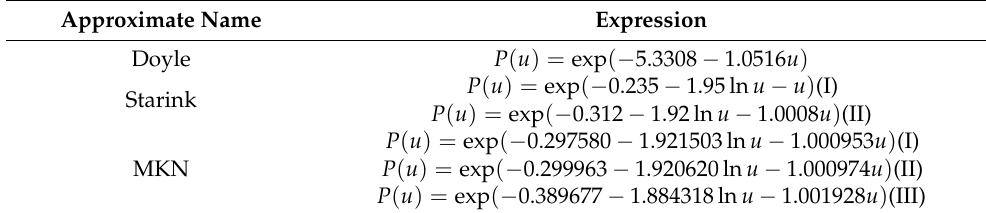
Table 2. Temperature integral approximation in exponential